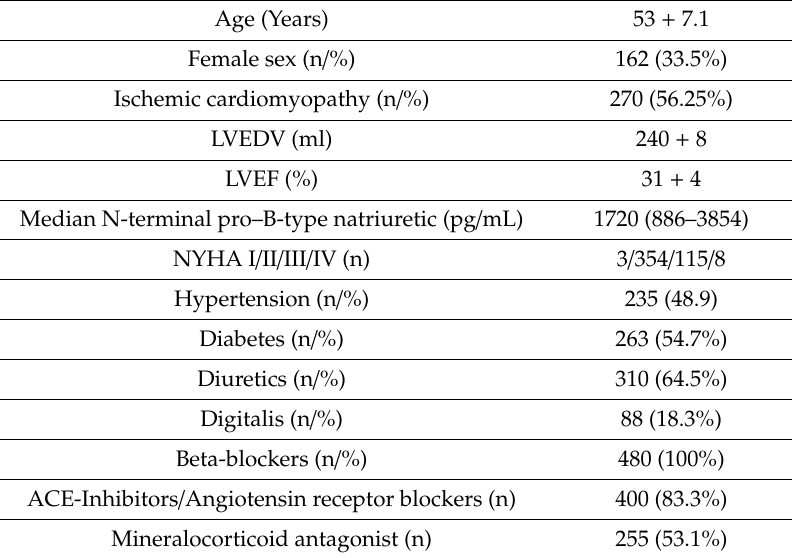
Table 2. Demographic and clinical characteristic of the study